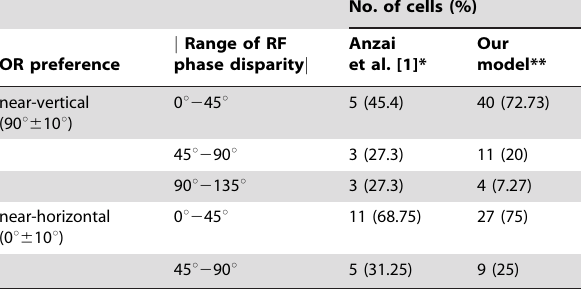
Cell population data